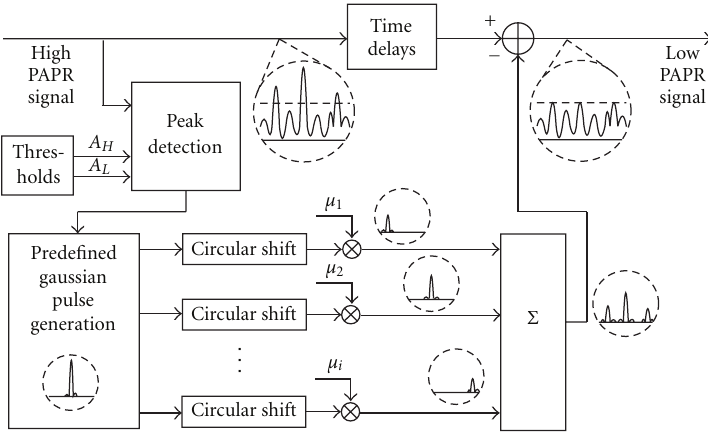
Figure 5: Block diagram of the proposed TTPSTR algorithm.